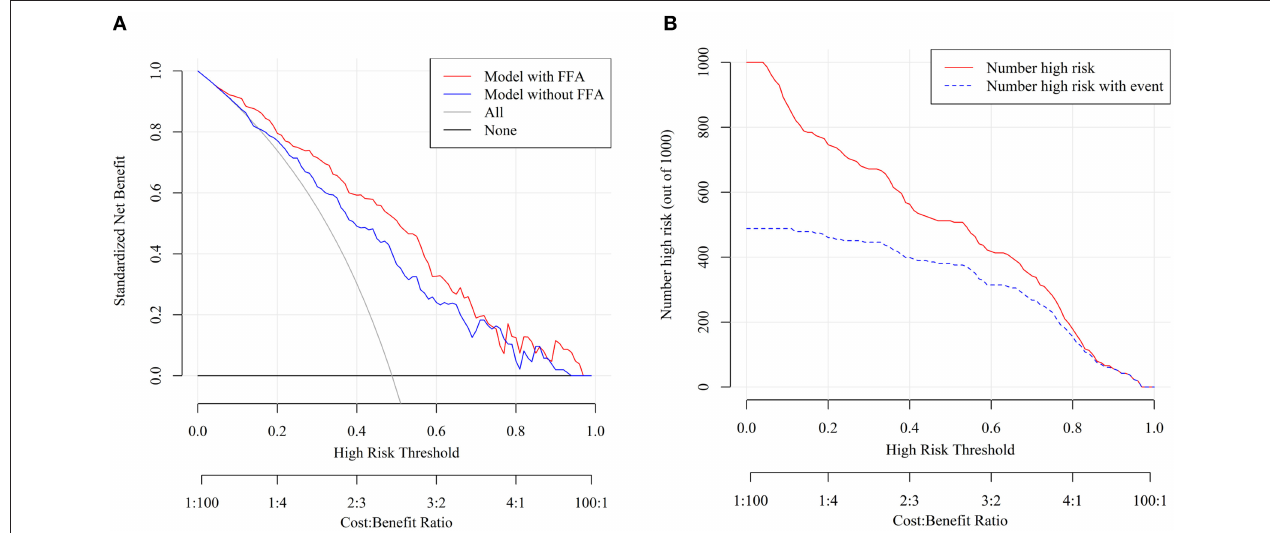
FIGURE 4 | Decision curve analysis (DCA) and clinical impact curve of nomogram. (A) The x- and y-axes represented the threshold probability and the net benefit, respectively. The red line represented the nomogram. The blue line represented the assessment model constructed by age + HH + mFS + aneurysm location. The gray line represented the net benefit that all patients are treated. The black solid line represented the net benefit of the strategy of treating no patients. (B) The red curve showed the predicted number at different threshold probabilities and the blue curve represented the actual number of patients for a population size of